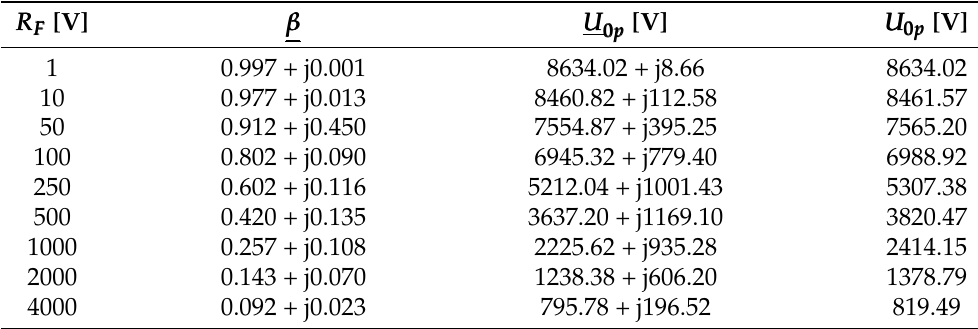
Table 5. Values of zero-sequence voltage measured in the compensated network with the previously mentioned parameters with U n = 15 kV for various R F transition